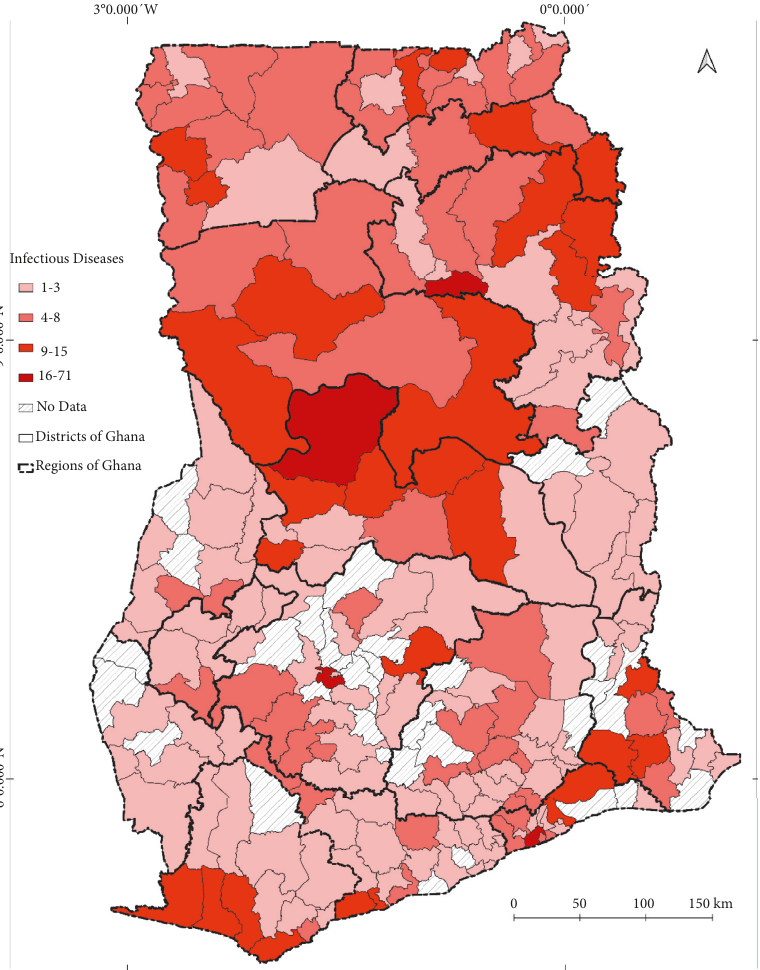
Figure 2: Distribution and intensity of endemic or potentially endemic infectious diseases studied in Ghana from 2000 to 2020. The legend indicates the number of infectious diseases studied in each district across the country. For instance, 1 was the least number of infectious diseases studied in a given district and 71 was the highest number studied. The intensity classifications were generated based on quantile to assign the same number of data values to each class from the ArcGIS software used to develop the